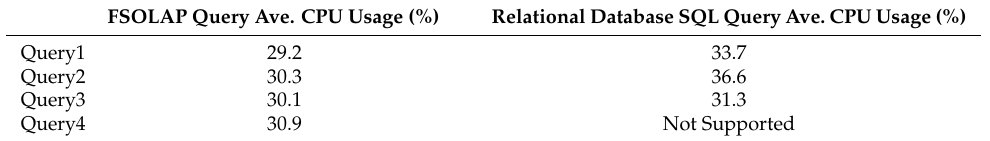
Table 5. Comparision of average CPU usages between FSOLAP and relational database SQL